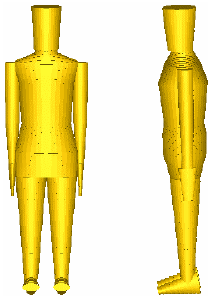
Fig. 2 Modeled human body in simulation method